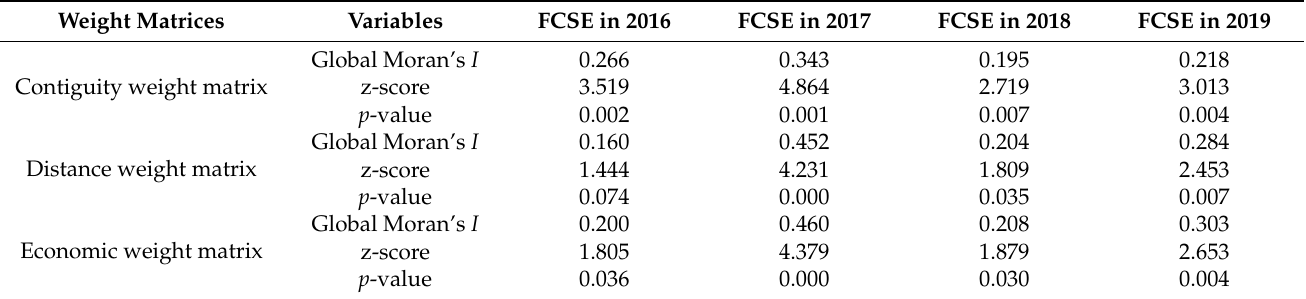
Table 2. Global Moran’s I of forest carbon sequestration efficiency under different weight matrices.